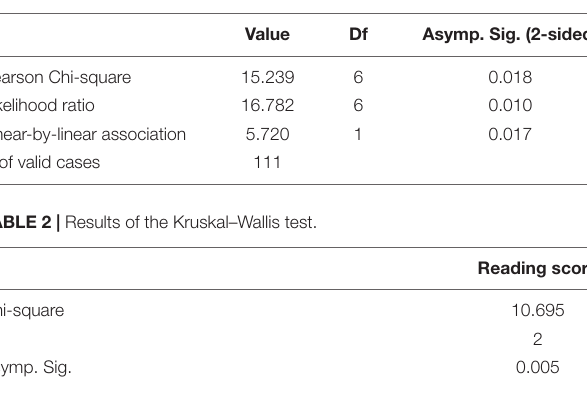
TABLE 1 | Results of Pearson Chi-square test.